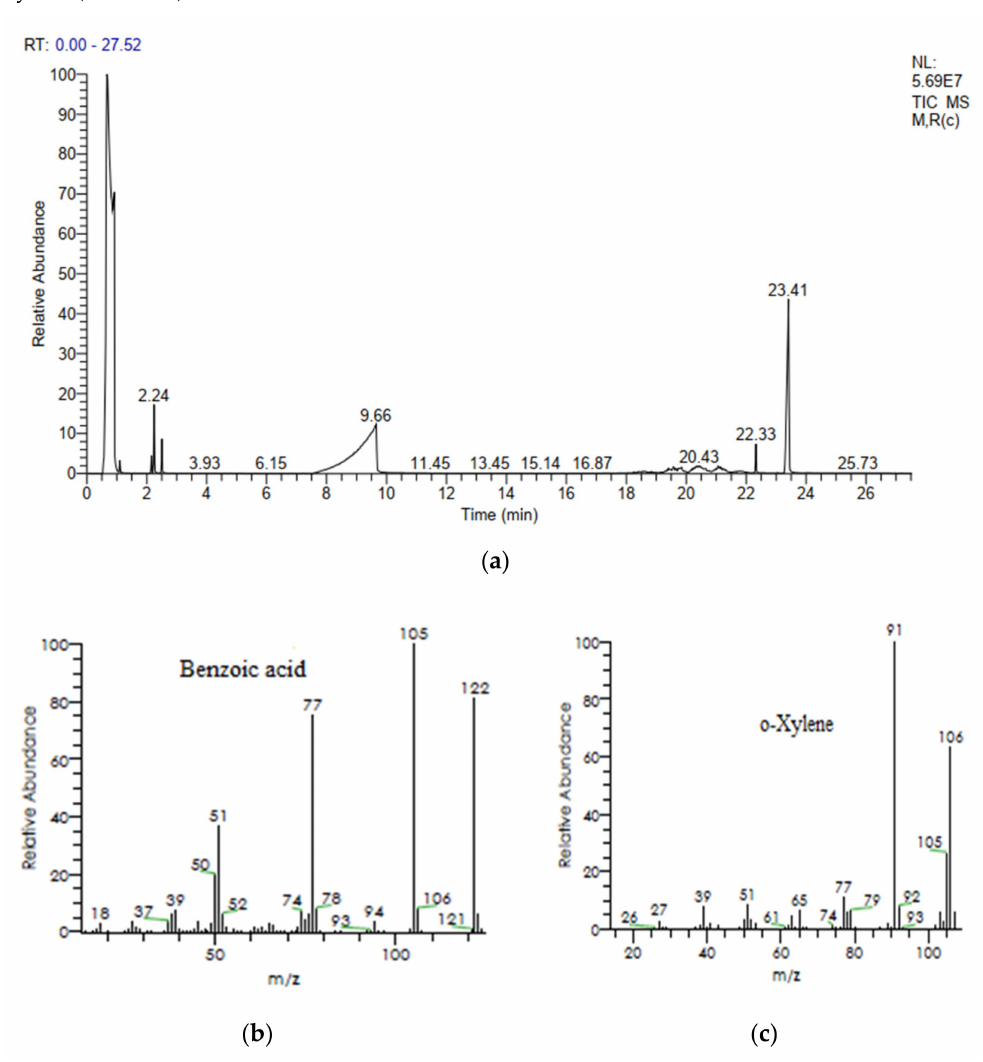
Figure 13. ( a ) GC chromatogram of methyl red after bacterial degradation; ( b , c ) GC–MS chro- matograms of two important metabolites. Table 5. Identified metabolites in the dye-degraded mixture from GCMS